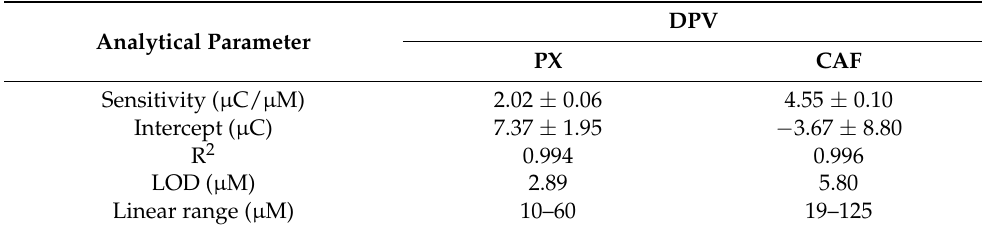
Table 1. Analytical parameters for the simultaneous quantification of paraxanthine (PX) and caffeine (CAF) in spiked saliva by DPV.